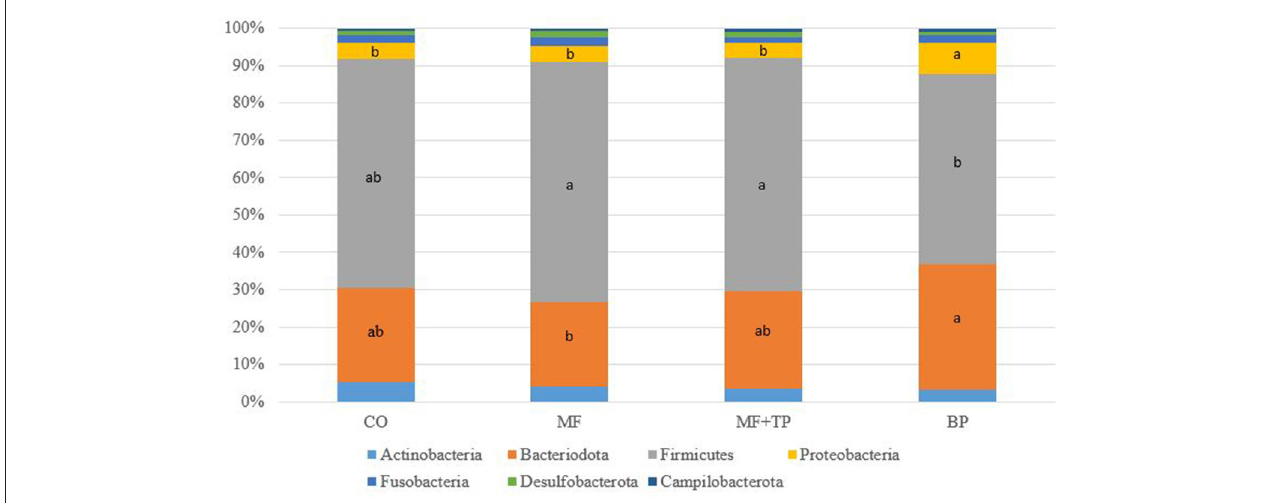
FIGURE 1 | Fecal microbial composition at the phyla level for cats fed diets containing traditional and novel fiber sources.